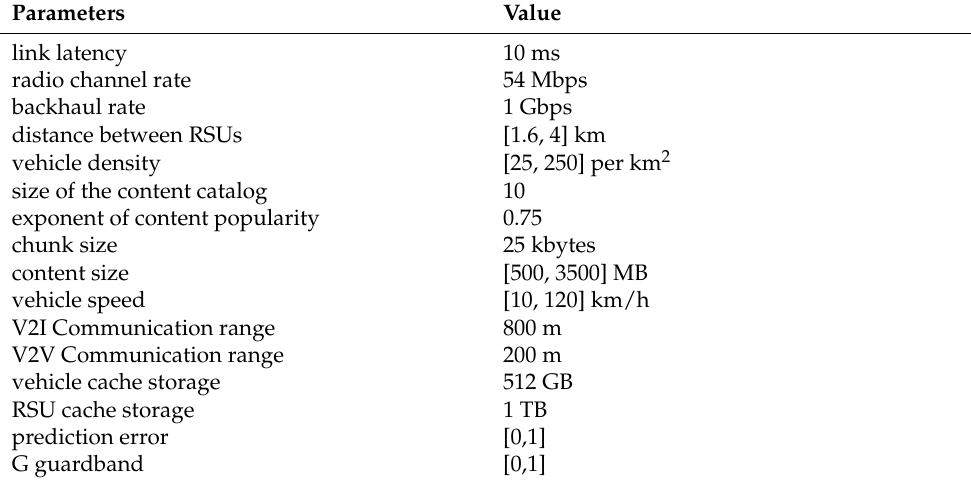
Table 3. Simulation